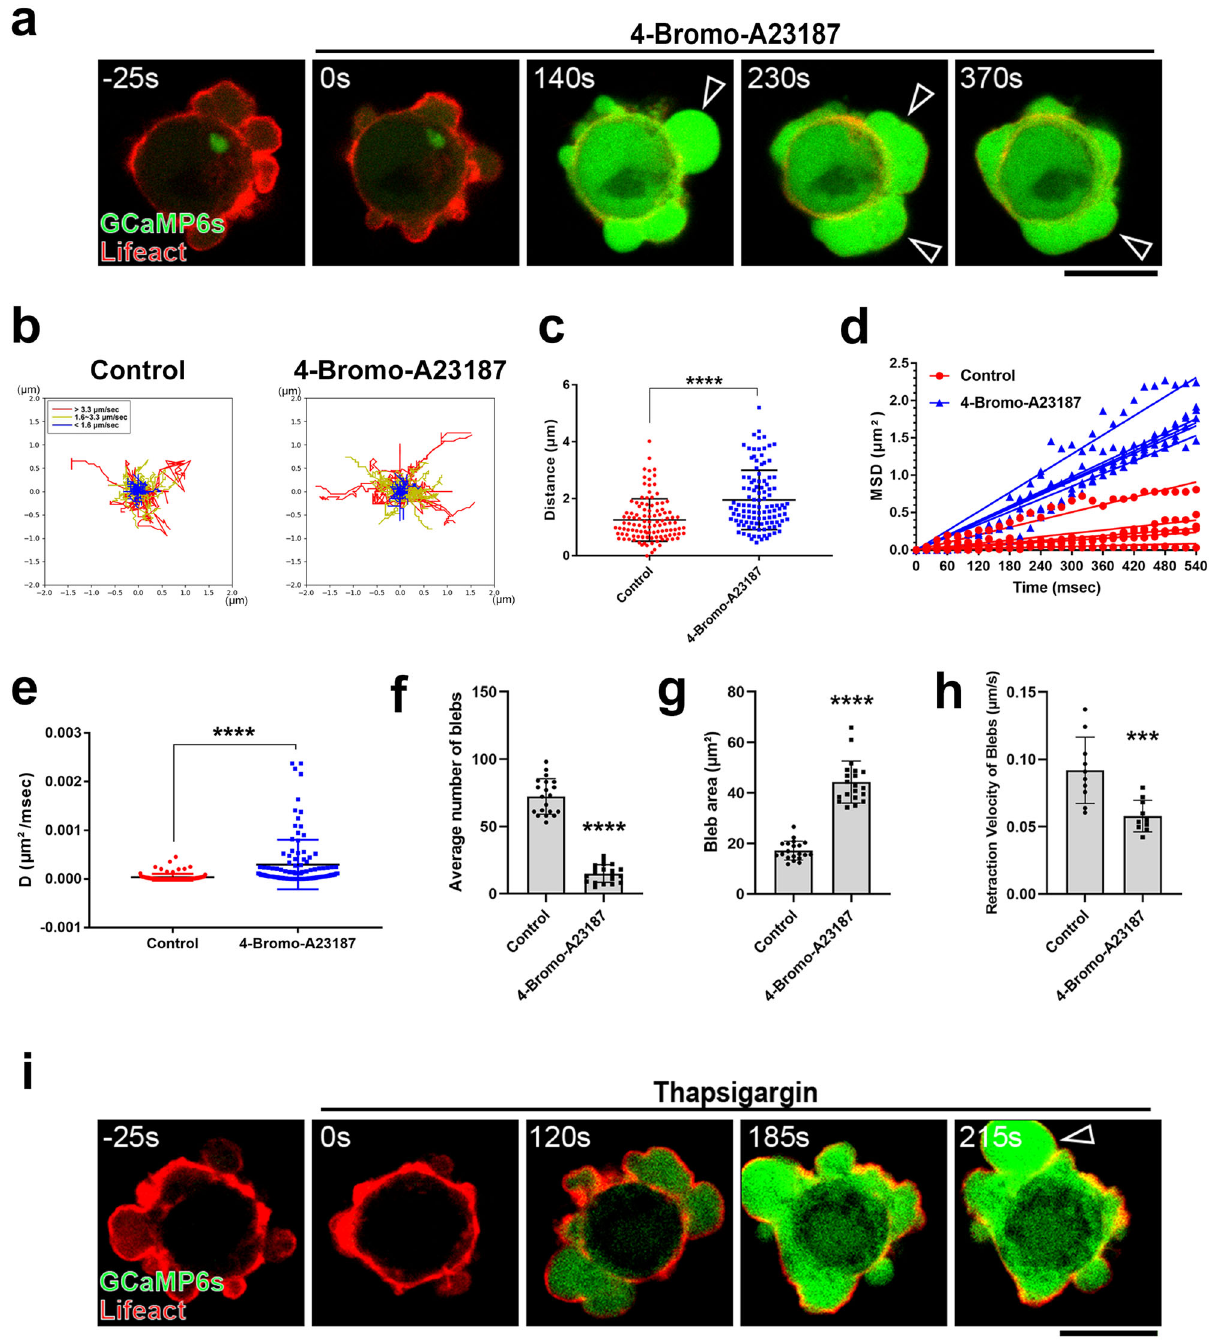
Fig. 3 Arti fi cially increasing the cytoplasmic calcium ion concentration upregulates cytoplasmic fl uidity and exaggerates membrane blebbing. a Membrane blebbing of DLD1 cells expressing GCaMP6s and Lifeact-RFP treated with the calcium ionophore 4-bromo-A23187 (10 µ M). Arrowheads show blebs fusing. Result shown is representative of three independent experiments. See also Supplementary Movie 4. b – e QDs dynamics in the cell body of ionophore-treated cells. b Centered trajectory maps showing the sum of the frame-to-frame distances over 600 msec (30 frames at 50 Hz; right). Red, yellow, and blue trajectories indicate diffusion velocities >3.3 μ m/s, >1.6 μ m/s and <3.3 μ m/s, and <1.6 μ m/s, respectively. c Cumulative distances of QDs motion. d Mean square displacement (MSD) analysis of fi ve representative trajectories per condition. e Diffusion coef fi cient ( D , μ m²/msec) was calculated from the slope of the fi tted regression line derived by MSD analysis of ( c ). N = 110 particles from 11 blebs from 10 independent cells per condition. c , e The number ( f , N = 20 cells), area ( g , N = 20 blebs) and retraction velocity ( h , N = 10 blebs) of membrane blebs in vehicle-treated (control) and ionophore- treated (4-bromo-A23187) DLD1 cells over 10 min from three independent experiments. i Membrane blebbing of DLD1 cells expressing GCaMP6s and Lifeact-RFP treated with the SERCA inhibitor Thapsigargin (1 µ M). Arrowhead shows increased GCaMP6s signal intensity in the bleb. Result shown is representative of three independent experiments. a and i Indicated times are relative to drug treatment. Scale bar, 10 μ m. c , e-h Individual data points are plotted with the means ± SD. **** P < 0.0001 (Two-sided, unpaired Student ’ s t test). Source data are provided as a Source Data fi le.